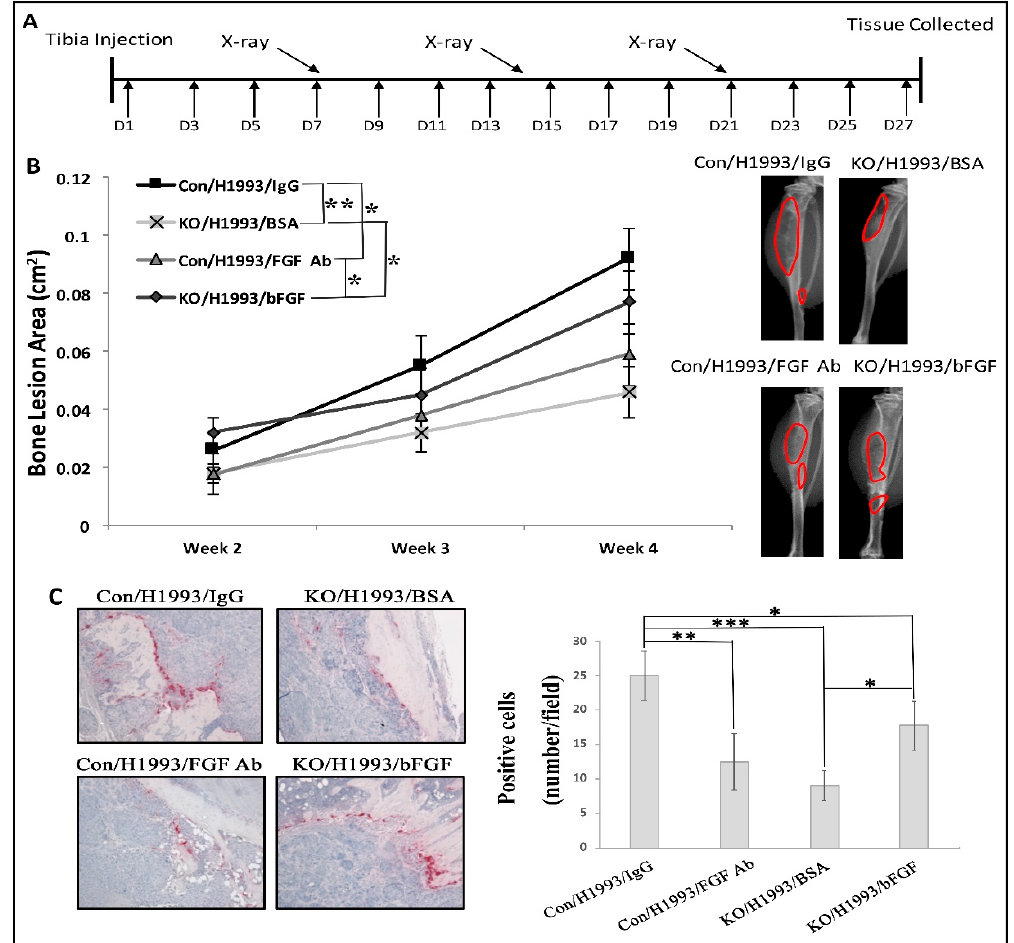
Figure 2. bFGF rescued H1993-induced lytic lesion development in Tgfbr2 LysMCre KO mice. ( A ) The schedule of drug treatment, X-ray image acquisition, and end-point tissue collection. ( B ) Quantification of bone lesion areas and representative X-ray images at 4 wk post-injection. ( C ) Representative TRAP staining (20 × ). Mean ± SD, n ≥ 7 per group. *** p < 0.001, ** p < 0.01, * p ≤ 0.05, by linear mixed-effect models for bone lesions or by ANOVA for quantification of TRAP.